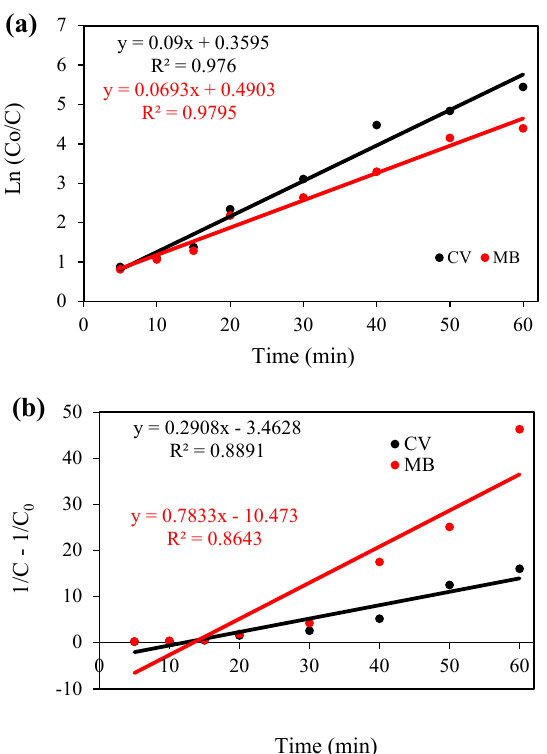
Figure 10. ( a ) Pseudo-first-order kinetic model and ( b ) pseudo-second-order kinetic model for the degradation of the desired dyes using the sono-photocatalytic process. Table 2. Rate constant comparison of pseudo-first-order kinetic model and sono-photocatalytic performance of Cloisite 30B/ZnO/Ag 2 O with other photocatalysts used for dyes